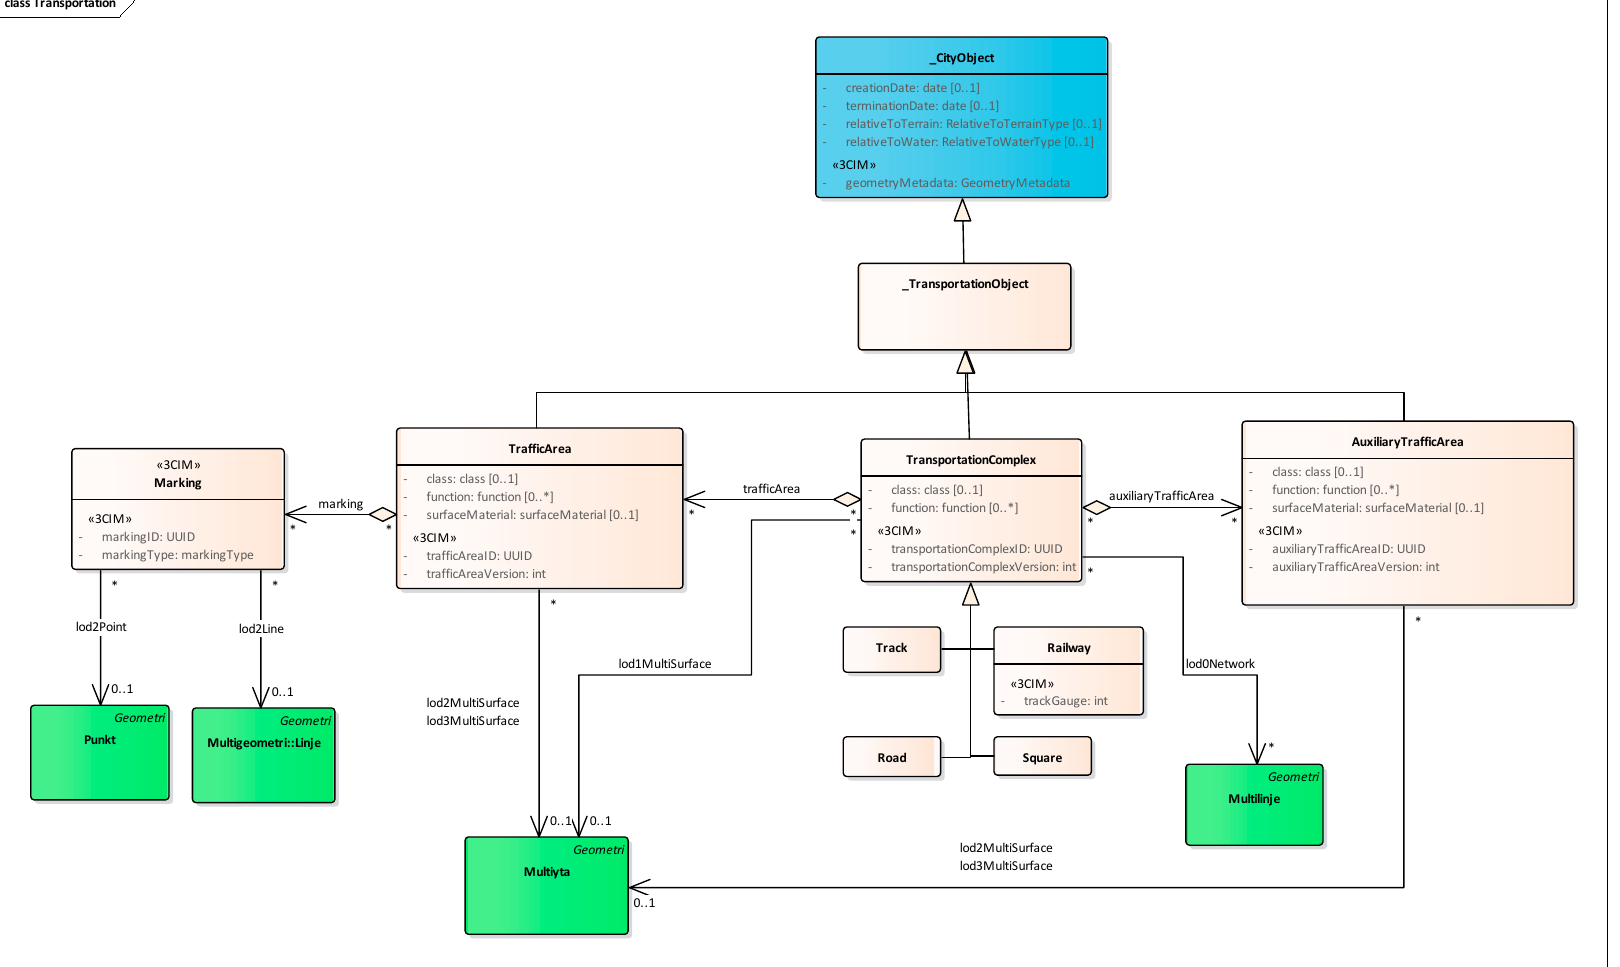
Figure 3. UML diagram of the transportation theme ADE. The ADE attributes are added below the namespace <<3CIM>> in the CityGML classes, and the ADE class marking has the namespace <<3CIM>> added before the class name.